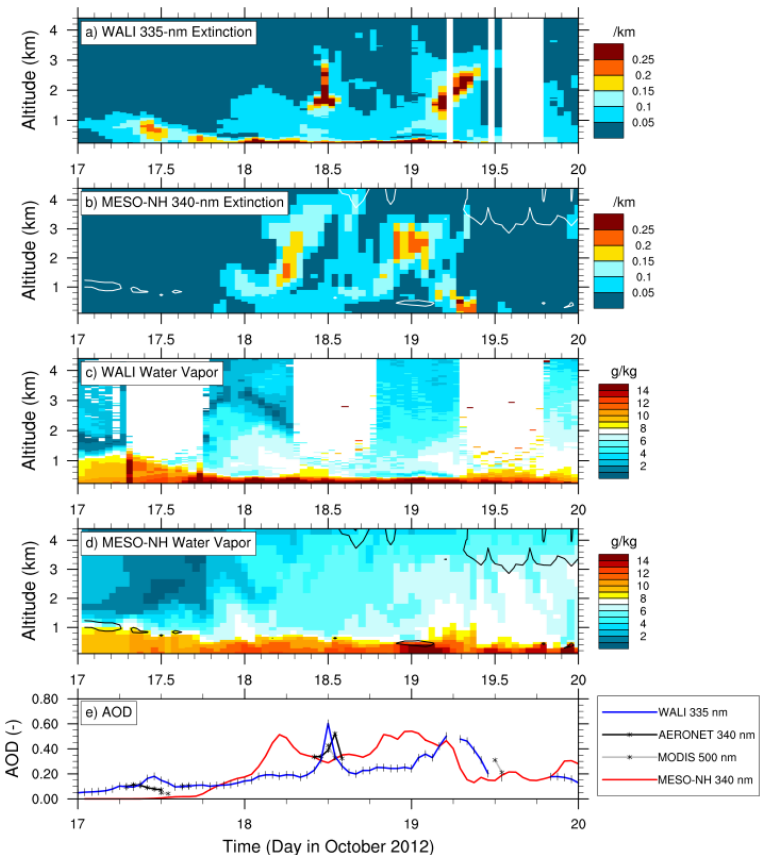
Figure 5. Time–height series of extinction coefficients derived from (a) WALI at 355nm and (b) the Meso-NH DUST simulation – valid for the spectral range 0.25–0.44µm – over Menorca between 00:00UTC on 17 October and 00:00UTC on 20 October 2012. Data gaps in (a) appear in white and are due to rain. (c) and (d) same as (a) and (b) but for the water vapor mixing ratio. The cloud layers in the Meso-NH DUST simulation are shown using a cloud condensate mixing ratio of 0.005gkg − 1 (white contours in b and black contours in d ). (e) AOD evolution for the same time period as derived from WALI (blue solid line), AERONET (at 340nm, black solid line), MODIS (grey solid line) and the Meso-NH DUST simulation (red solid line). Error bars on the AOD retrievals are ± 0.03 and ± 0.02 for AERONET and WALI retrievals,